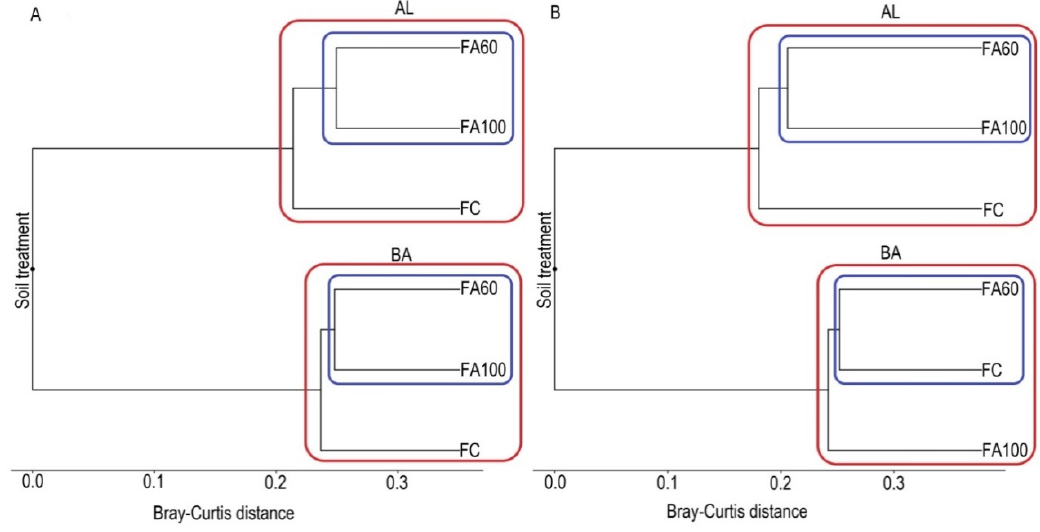
Figure 10. Cluster UPGMA dendrograms based on Bray-Curtis distances for soil bacterial ( A ) and fungal ( B ) communities. Explanation: FC—optimal dose of fertilizer, FA100—optimal dose of fertilizer enriched with microorganisms, FA60—fertilizer enriched with microorganisms (dose reduced by 40%), BA—Brunic Arenosol, AL—Abruptic Luvisol.